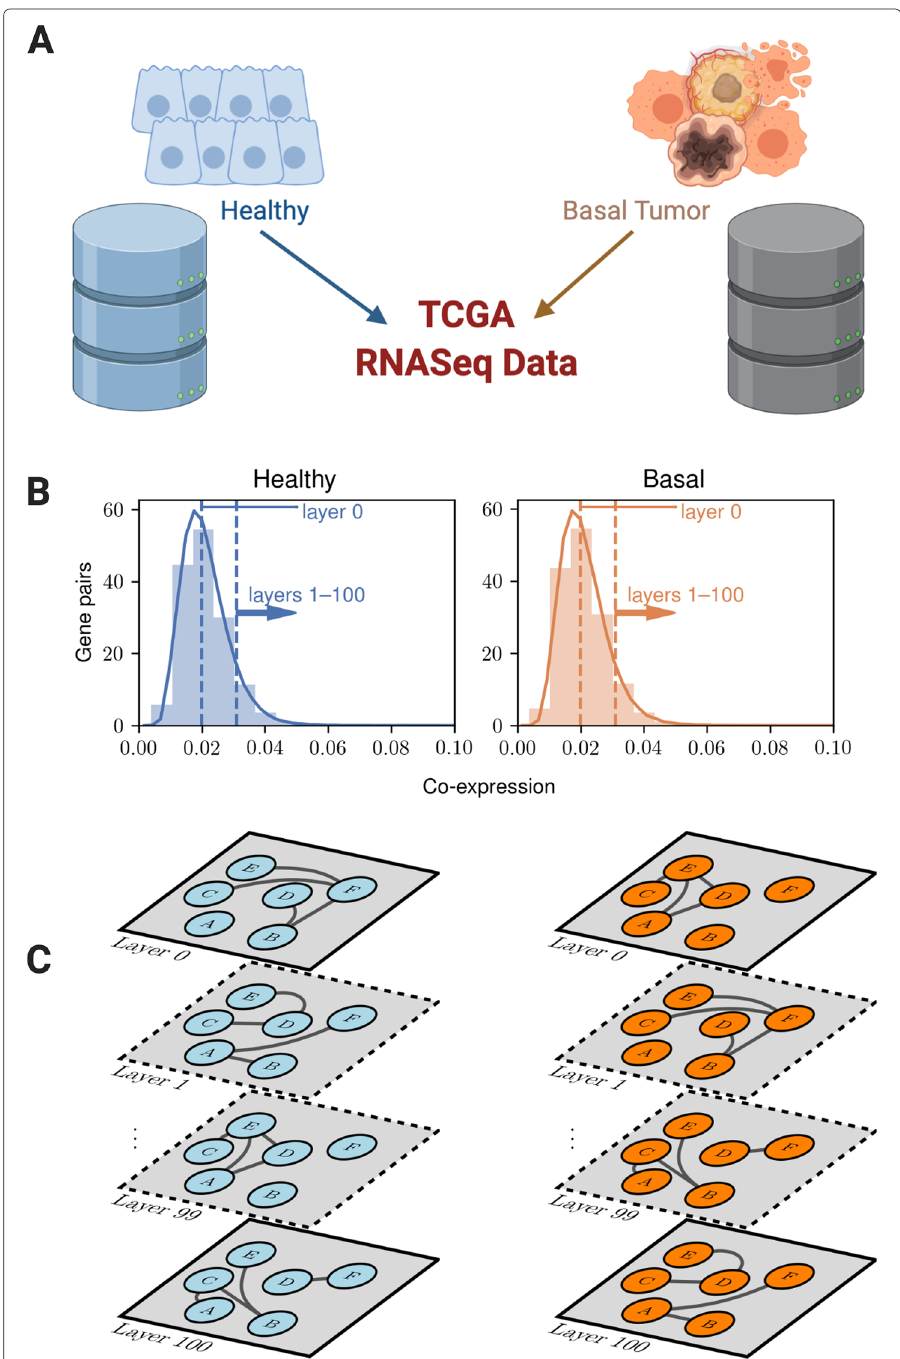
Fig. 1 Workflow to obtain the multilayer networks of healthy and breast cancer (Basal-like) phenotypes. a ) Data acquisition. b ) Gene Co-expression distribution obtention. c ) Multi-layer Gene Co-expression Networks